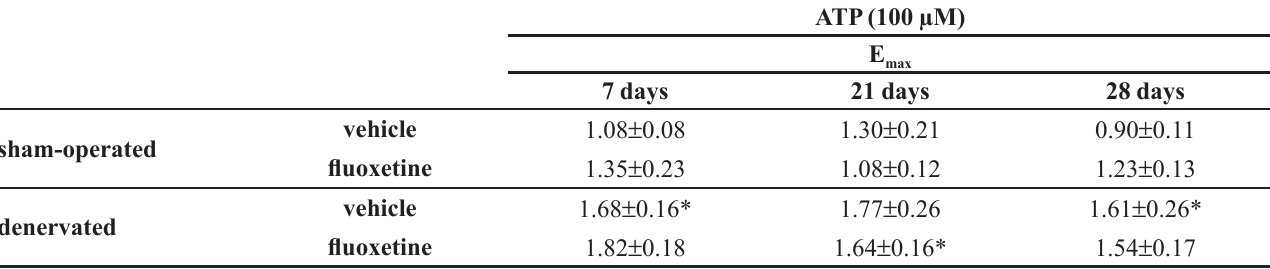
), in grams of tension, from a single concentration of ATP (100 µM) obtained in TABLE II - Maximum amplitude of contraction (E max vas deferens from sham-operated and denervated rats treated with vehicle or fluoxetine for 7, 21 and 28 days. Each value represents the mean ± standard error of 5 to 8